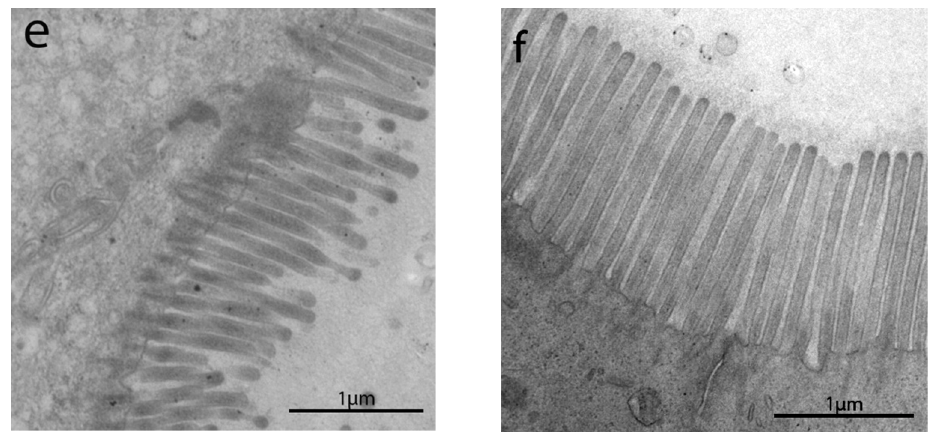
Figure 2. TEM images in IBS-like disorders: uCD ( a ); tCD ( b ); WA ( c ); NCGS ( d ); Ni ACM ( e ); controls ( f ). In uCD it is possible to appreciate severe atrophy of the microvilli. The restitutio ad integrum of the microvilli in tCD ( b ) is however not similar to the controls ( f ). In NCGS ( d ) and Ni ACM ( e ) microvilli appear hypotrophic and similarly distant from each other. The desmosome gap was found almost always significantly wider in uCD, NCGS, and Ni ACM than in tCD, WA, and control patients. No significant difference was found in the desmosome gap width among uCD, NCGS, and Ni ACM patients, although the largest distances were found in uCD and the shortest in Ni ACM. Similarly, no significant difference was observed in the desmosomes gap width among tCD, WA and controls patients.